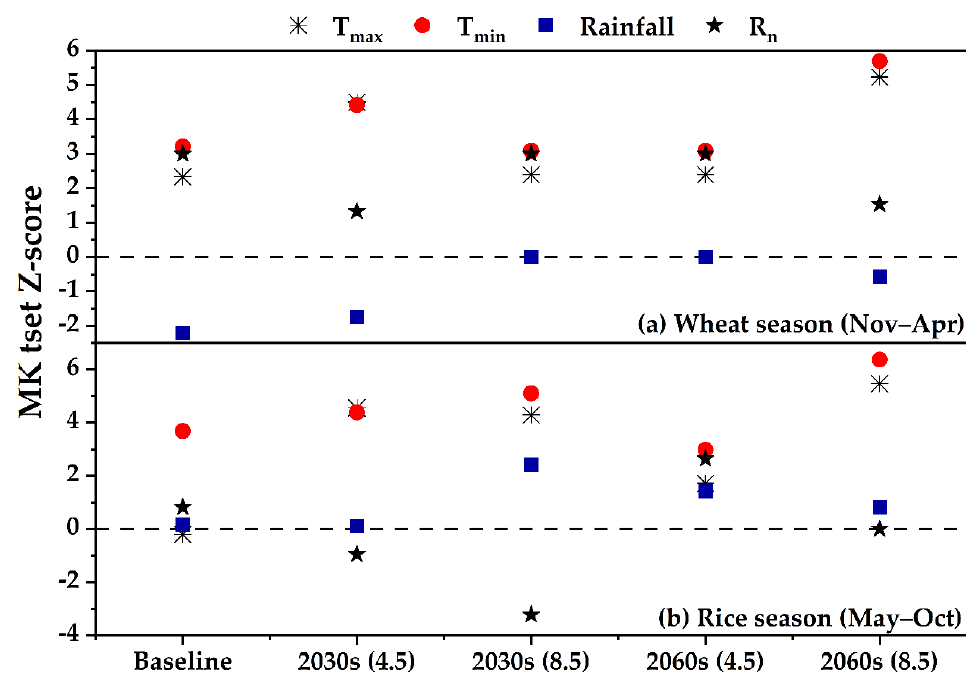
Figure 4. MK test Z-scores for ( a ) wheat season and ( b ) rice season climate change trends during the